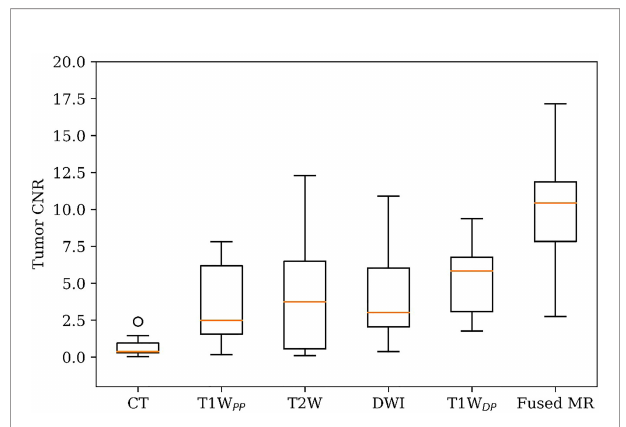
FIGURE 1 | Patient tumor CNR in planning CT, four original MR image sets, and fused MRI. CNR, contrast-to-noise ratio.